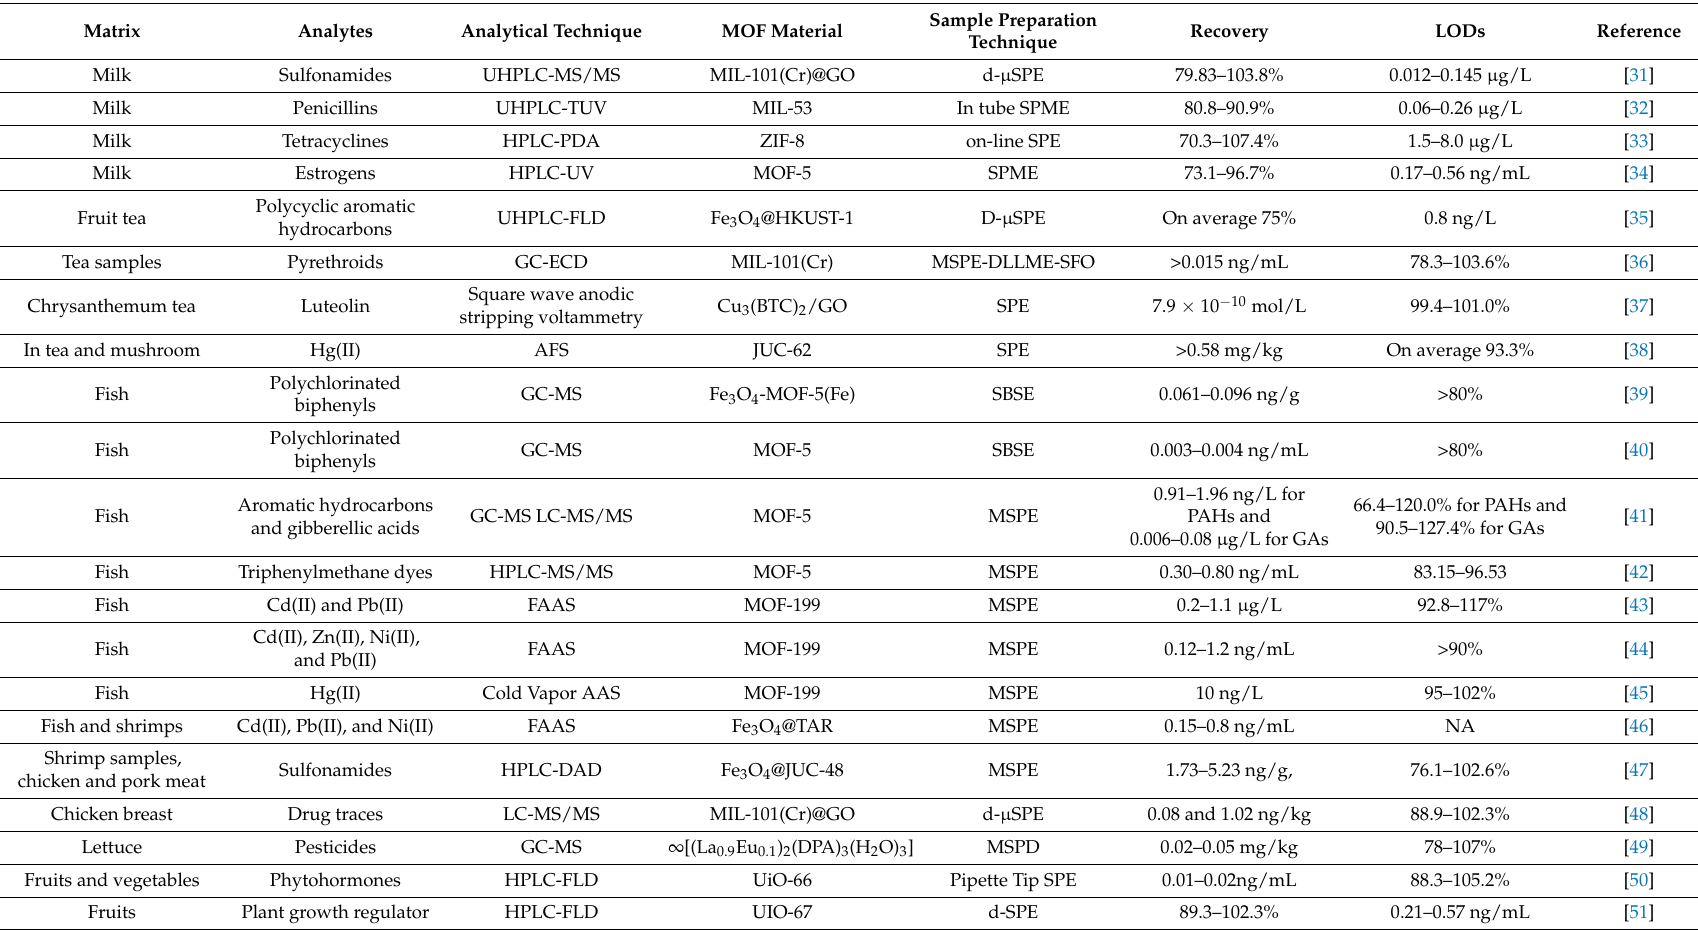
Table 1. Applications of MOF use for food sample